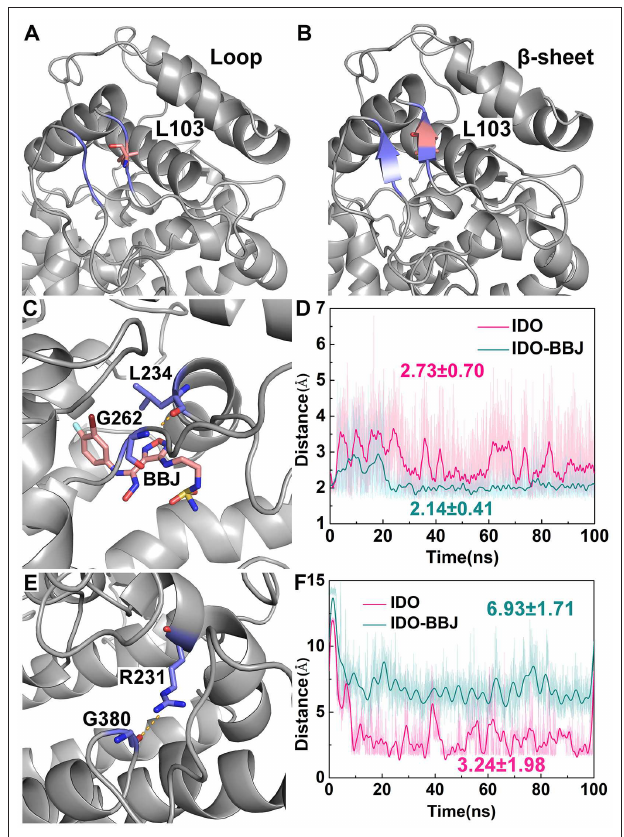
FIGURE 8 | Distance analyses of key residues. Overview of residues around L103 in IDO1 monomer (A) and IDO-INCB024360 complex (B) ; relative positions of INCB024360, G262 and L234 (C) , as well as distance variation of G262 with L234 over simulation time (D) ; relative positions of G380 and R231 (E) , as well as distance variation of G380 with R231 over simulation time (F) in the IDO and IDO-BBJ systems.